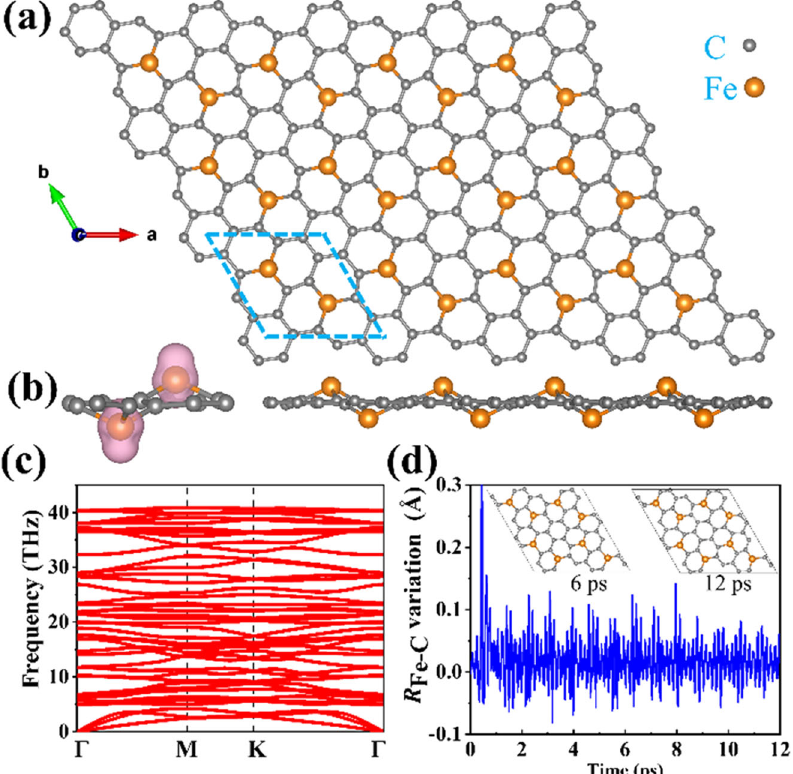
Fig. 3 Atomic structure and stability of 2D-Fe 2 C 12 . a Top- and side-view of the optimized 2D-Fe 2 C 12 monolayer with the primitive cell enclosed in cyan dashed lines. b The spin differential density plot of 2D-Fe 2 C 12 , showing that the magnetic moment is largely localized on the Fe atoms. c The phonon dispersion spectrum of 2D-Fe 2 C 12 . d Results of the AIMD calculation showing the Fe – C bond length variation at 300 K. Insets are snapshots of atomic structures at 6 and 12 ps.